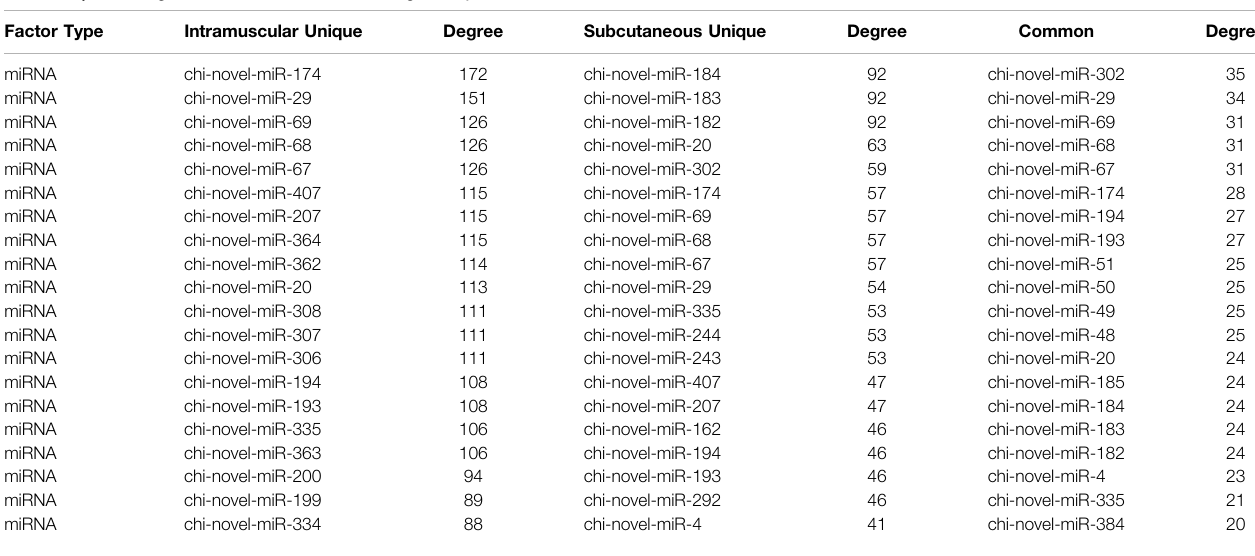
TABLE 6 | Node degree of mRNA-miRNA-lncRNA regualatory network. Factor